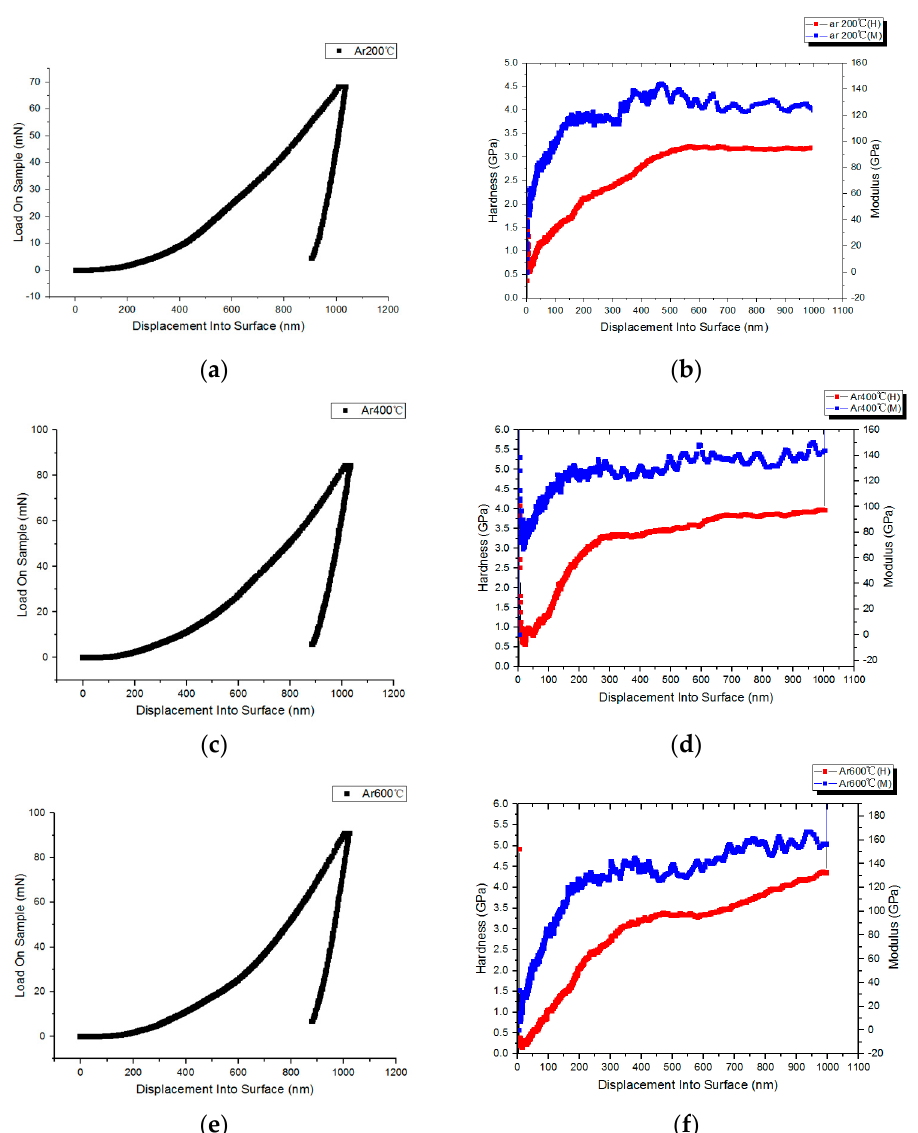
Figure 12. Characteristic load vs. nanoindentation depth for anodized samples annealed in Ar at ( a ) 200 °C, ( c ) 400 °C and ( e ) 600 °C. Hardness and modulus vs. nanoindentation depth for anodized samples annealed in Ar at ( b ) 200 °C, ( d ) 400 °C, and ( f ) 600 °C.